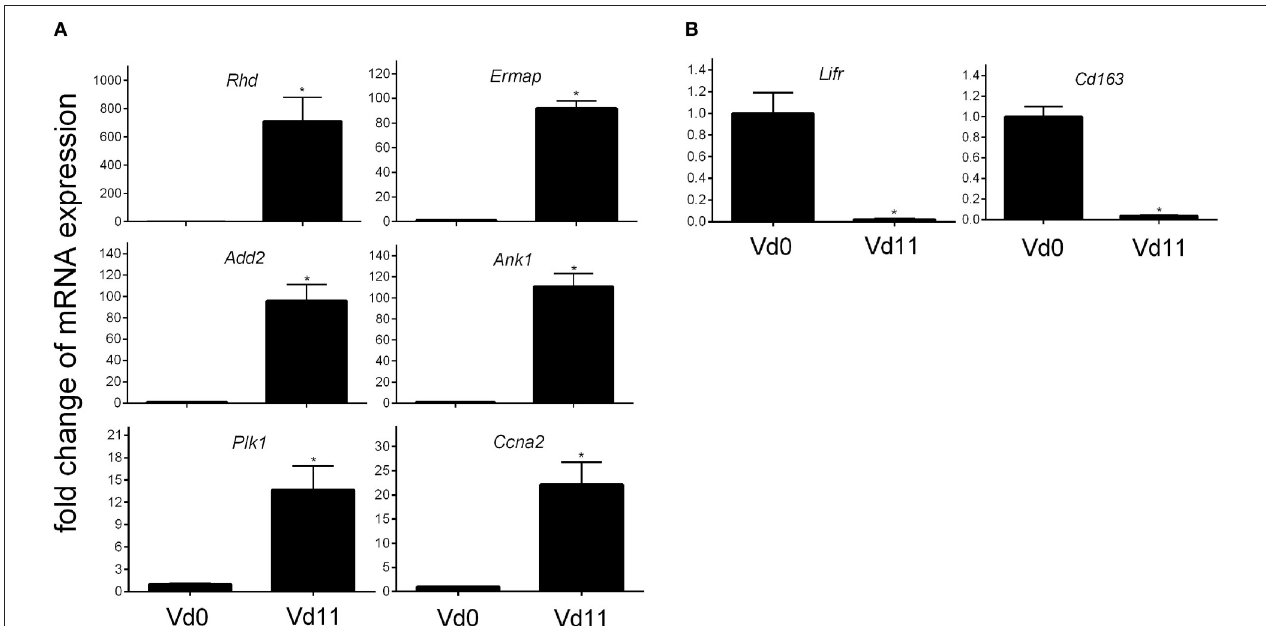
FIGURE 3 | Quantitative PCR of mRNAs of arbitrarily selected up-regulated (A) and down-regulated (B) genes in the liver of vaccinated Balb/c mice infected with P. chabaudi on day 0 p.i. (Vd0) and on day 11 p.i. (Vd11). Values are means of triplicate determinations. Bars indicate half SEM and stars significant differences ( p < 0.01) between Vd0 and